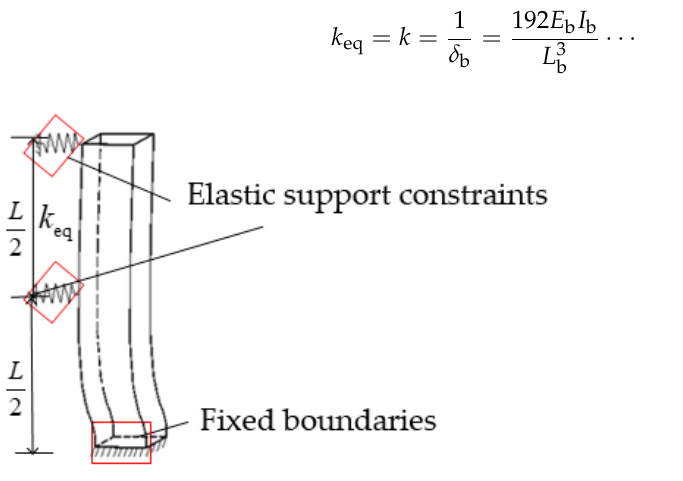
Figure 7. Mechanical model of wall column.